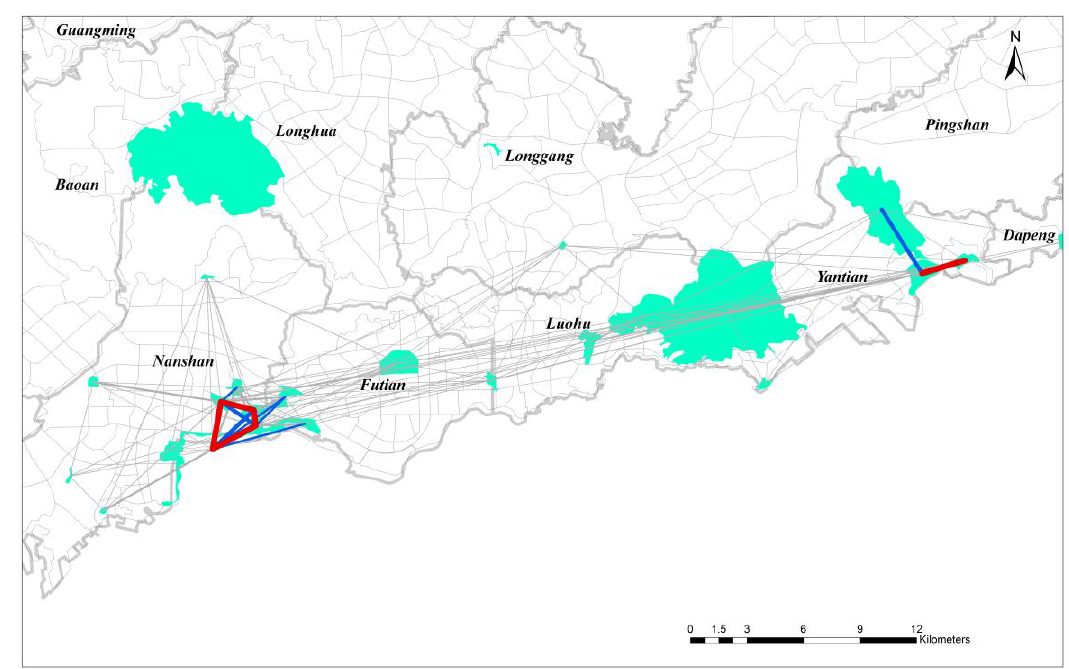
Figure 13. Spatial interaction intensity of